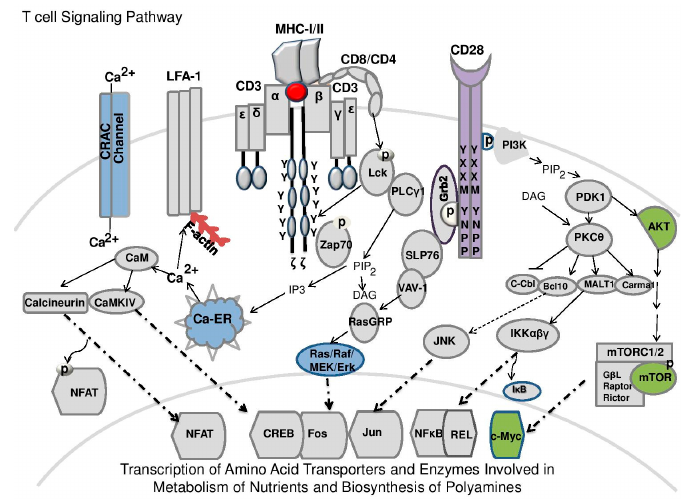
Figure 2. Proximal T-cell signaling cascade. Proximal signaling pathways downstream of the T-cell receptor (TCR)-antigen presenting cell (APC)ignaling complex (as described in Figure 1) are responsible for the cascade of events leading to metabolic reprogramming including the transcription of amino acid transporter and enzymes involved in metabolism of nutrients and biosynthesis of polyamines [85]. Phosphorylation of the immunoreceptor tyrosine-based activation motifs (ITAMs) on the cytoplasmic side of the TCR/CD3 complex engage numerous cascading interactions largely mediated by phosphorylation, dephosphorylation or ubiquitinylation resulting in cellular activation [61]. The initiating signal is generated by lymphocyte protein tyrosine kinase (Lck) and other proto- oncogene tyrosine-protein kinase (Src) family tyrosine kinases including the zeta-chain associated protein kinase (Zap-70) that is recruited to the TCR/CD3 complex. Costimulation through leukocyte- associated antigen-1 (LFA1) which is an integrin involved in T-cell migration or CD28 interaction with CD80 (B7-1) or CD86 (B7-2) (see also Figure 1) activates the phosphorylation of the YXXM or YNPP signaling motifs [86] which regulates glucose metabolism. CD28 leads to stable recruitment of the adaptor protein Grb2/GADS along with interleukin-2-indicible T-cell kinase (Itk), Lck, and phosphatidylinositide 3 kinase (PI3K) heterodimer p85/p110 and SLP76. These interactions promote the activation of VAV-1, RasGRP, and the Ras/Raf/MEK/Erk pathway downstream of phosphorylated SLP-76 and Zap-70 modulating the TCR signal strength [86]. A complement of transcription factors nuclear factor of activated T-cells (NFAT), cAMP response element-binding protein (CREB), Fox family transcription factor c-Fos, Jun (when in combination with c-Fos forms the AP-1 early response transcription factor complex, nuclear factor kappa-light-chain-enhancer of activated B cells (NF κ B), an NF κ B family member c-Rel, and c-Myc which coordinately regulate gene expression. Activation of CD28 leads to the phosphorylation of PI3K, phosphatidylinositol-3,4 bisphosphate (PIP2) and phosphoinositide-dependent kinase 1 (PDK1) [87] which integrates the TCR and CD28 signaling to induce the NF κ B pathway including protein kinase C-theta (PKC- θ ), and inhibits the ubiquitin ligase c-Cbl [88] leading to activation of Bcl10, Malt1, Carma1 (CBM) complex leading to IKK αβγ activation of NF κ B and REL [87]. In addition to PKC- θ , phosphorylation of Akt is critical for the regulation of mTORC1 and mTORC2 complexes of mTOR that bind G β L and raptor or rictor, respectively [79,81]. This is a critical step in c-Myc-dependent transcriptional regulation that stimulates dramatic changes in metabolism including glucose, amino acid, nucleotide and polyamine biosynthesis [63,89]. Divalent cations such as calcium (Ca 2+ ) are induce downstream of phospholipase C γ 1, PIP2, and indo inositol-1,4,5 triphosphate (IP3) which mobilizes the release of intracellular Ca 2+ stores from the endoplasmic reticulum (Ca 2+ -ER) a potential metabolic switch that suppresses intratumoral T-cell function [90]. Sustained signaling then promotes the influx of extracellular Ca 2+ into the cells through calcium release-activated Ca 2+ (CRAC) channels. Calcium- calmodulin interactions (Ca 2+ /CaM) then activates the phosphatase calcineurin and calcium/calmodulin-dependent protein kinase type IV calmodulin (CaMKIV), which dephosphorylates the cytoplasmic subunits of nuclear factor of activated T-cells ( NFAT) exposing a nuclear localization signal resulting in nuclear transport and phosphorylates CREB, respectively.